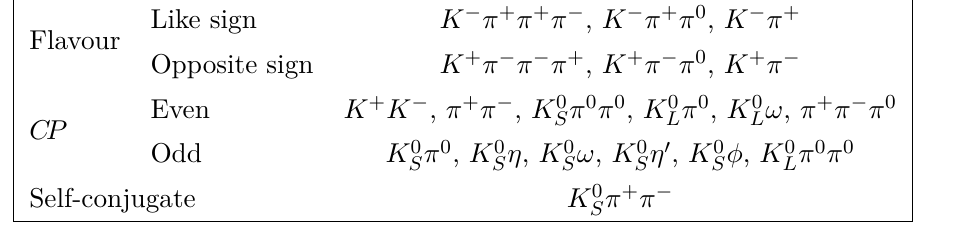
Table 1 . Summary of tag modes selected against the signal decays D → K − π + π + π − and D → K − π + π 0 . The CP tags are also reconstructed against the decay D → K − π +